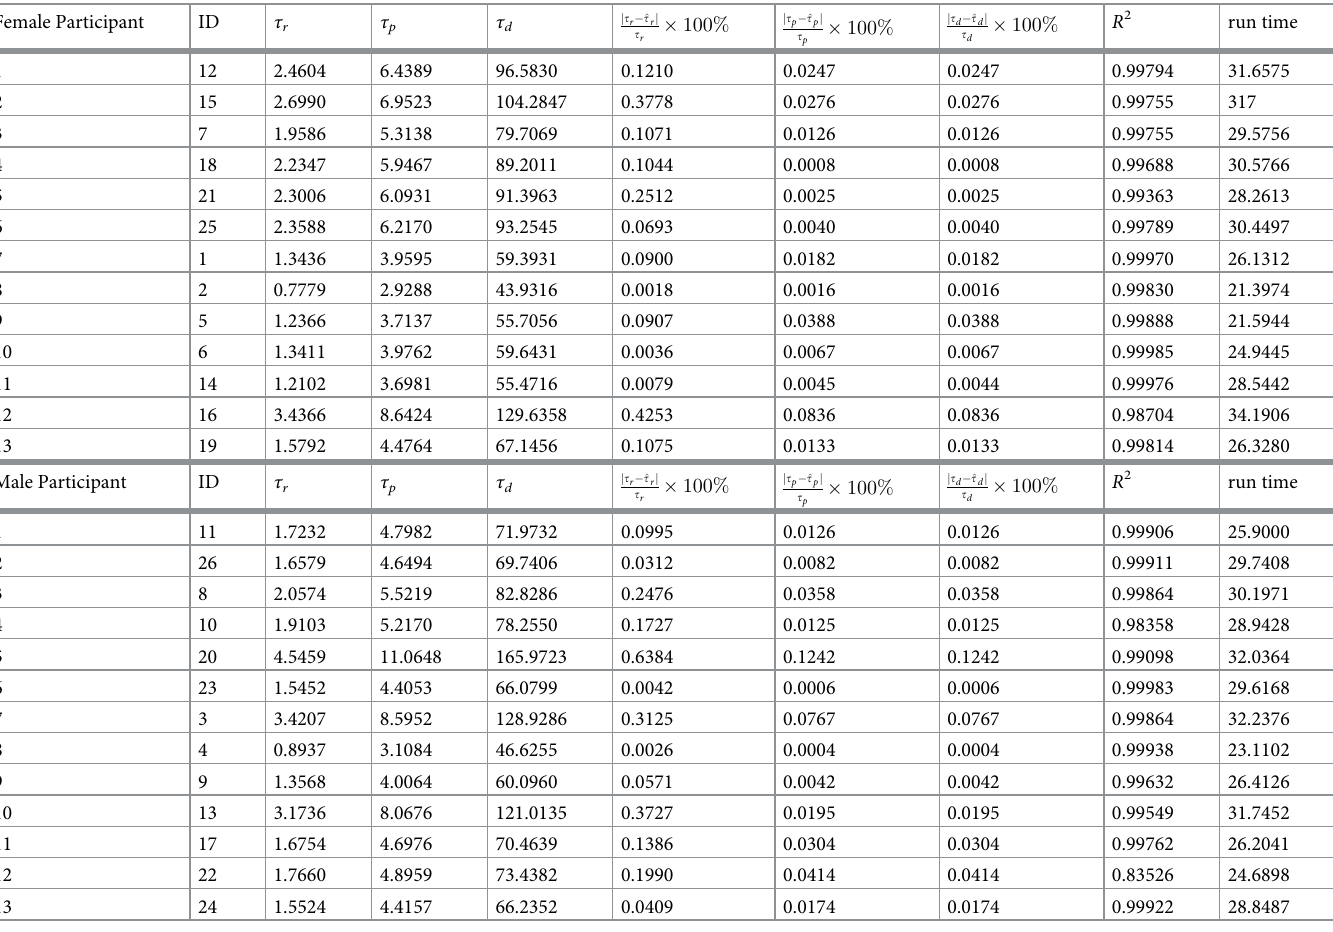
Table 2. The estimated model parameters, estimation errors, and the squares of the multiple correlation coefficients ( R 2 ) for the fits of the simulated SC data. Female Participant